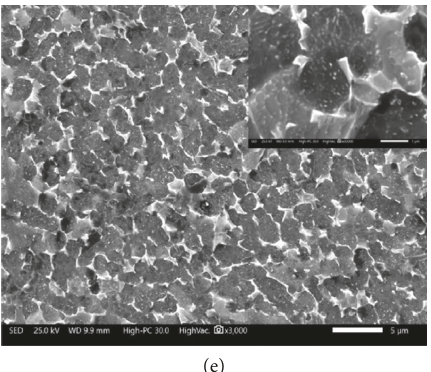
Figure 7: Microstructural characteristics of the Ti6Al4V biomaterials: (a) USA; (b) Germany; (c) China; (d) Brazil; (e)